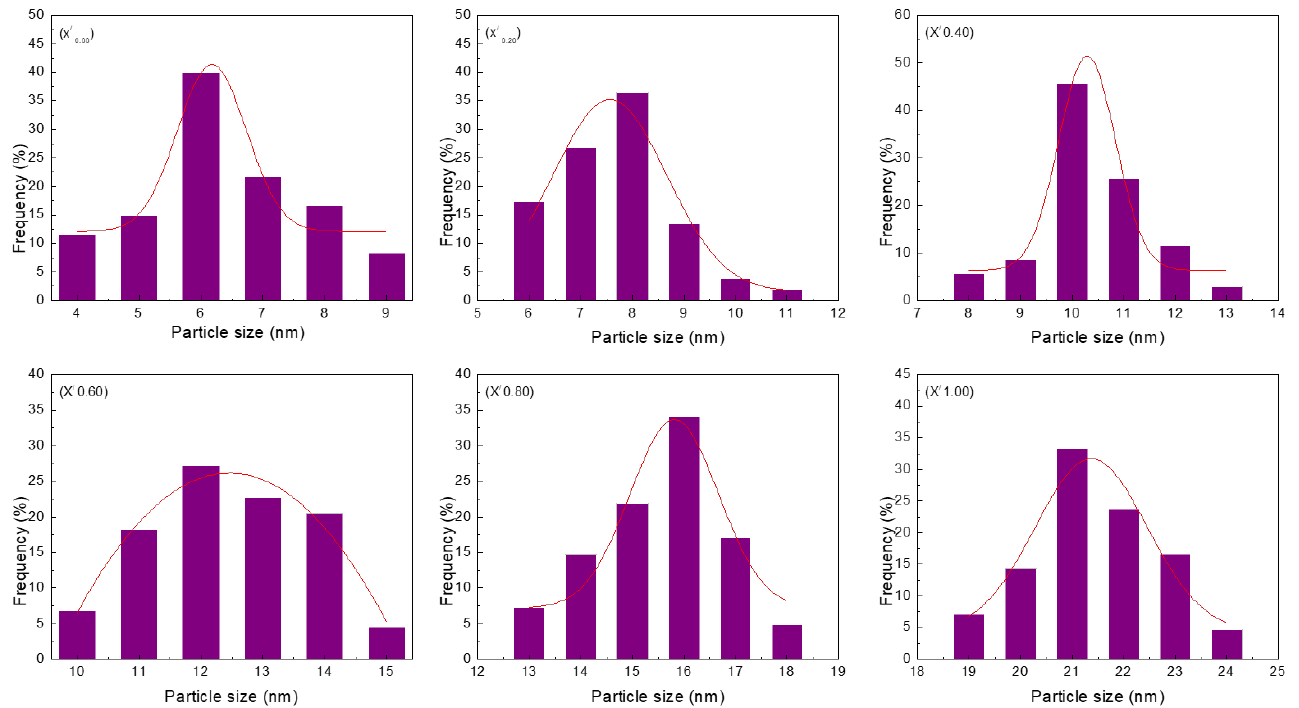
Figure 4. Particle size distribution of (x / 0.00 ) Ce 0.00 Sn 1.00 O 2 , (x / 0.20 ) Ce 0.20 Sn 0.80 O 2 , (x / 0.40 ) Ce 0.40 Sn 0.60 O 2 , (x / 0.06 ) Ce 0.60 Sn 0.40 O 2 , (x / 0.08 ) Ce 0.80 Sn 0.20 O 2 , and (x / 1.00 ) Ce 1.00 Sn 0.00 O 2 ) nanoparticles calcined at 650 ◦ C. Table 1. XRD and TEM results for Ce x Sn 1 − x O 2 nanoparticles of various x values when synthesized at 650 ◦ C. x